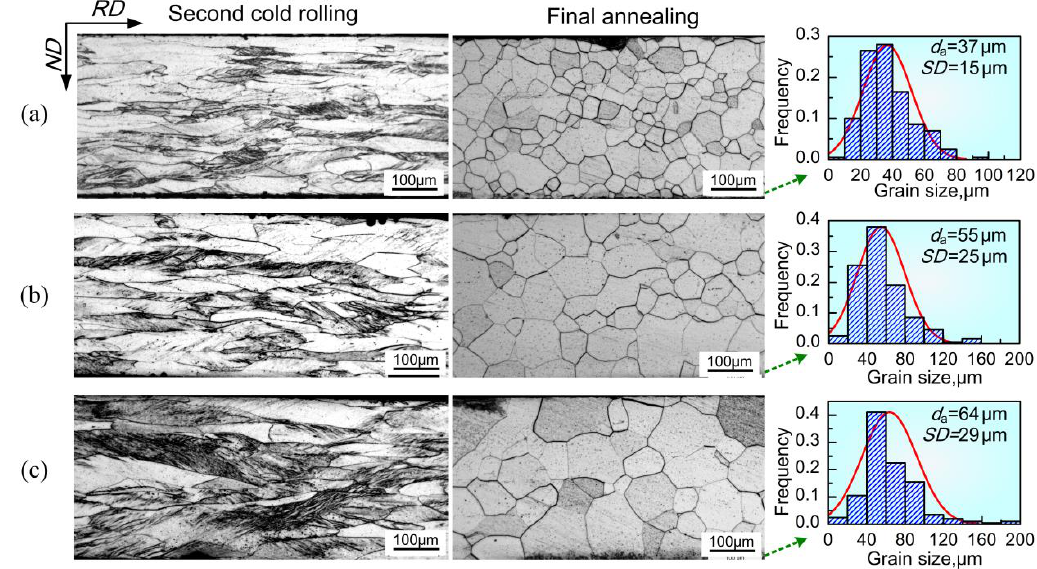
Figure 5. Microstructural evolution during second cold rolling and final annealing corresponding to ( a ) TCR9; ( b ) TCR10 and ( c ) TCR11 processes. ( a ) TCR9; ( b ) TCR10 and ( c ) TCR11